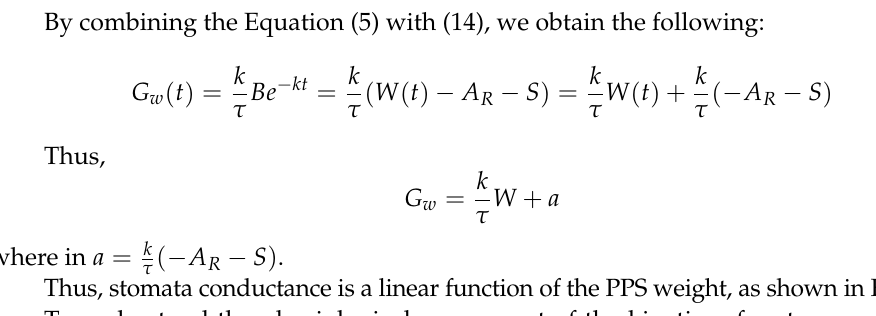
Figure 4. Modeling of stomatal conductance in response to water availability. ( a ) Empirical model representing the conductance over time and the empirical model adjustment. ( b ) Lineal regression between conductance and substrate weight. Gw: stomatal conductance; W: PPS weight; dwd: days of water deficit.